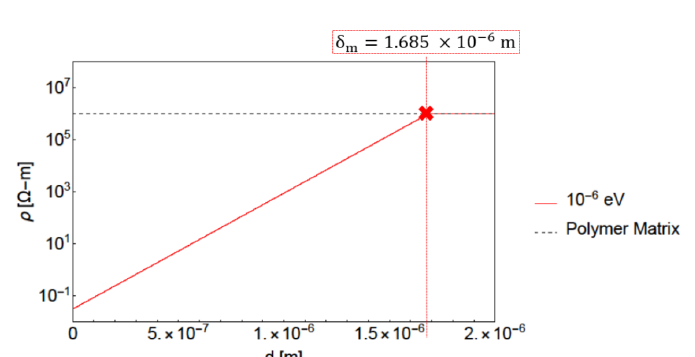
Figure 1. Plot of resistivity ρ vs. tunneling distance d on a log-linear scale for barrier potential λ = 10 − 6